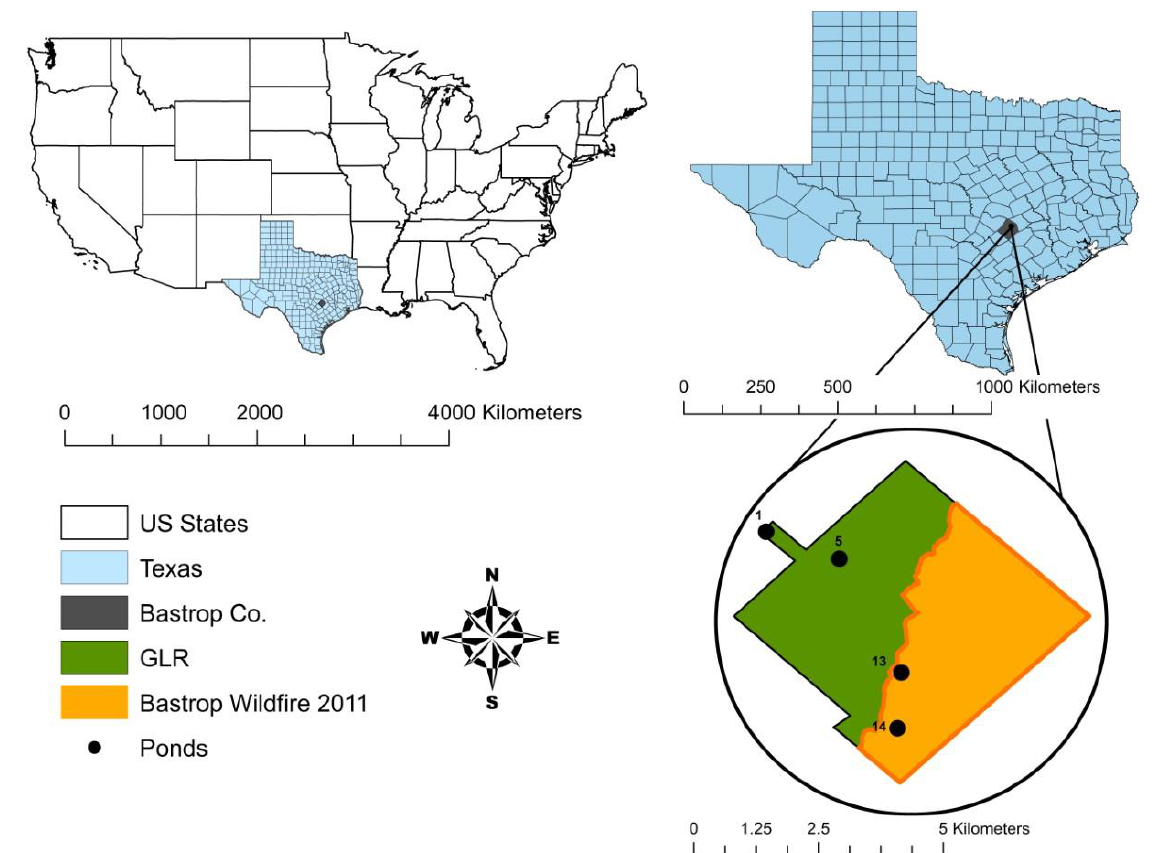
Figure 2. Location of the study ponds in unburned (grey, ponds 1 and 5) and burned (checkered, ponds 13 and 14) areas of the Griffith League Ranch (GLR) in Bastrop County, Texas.